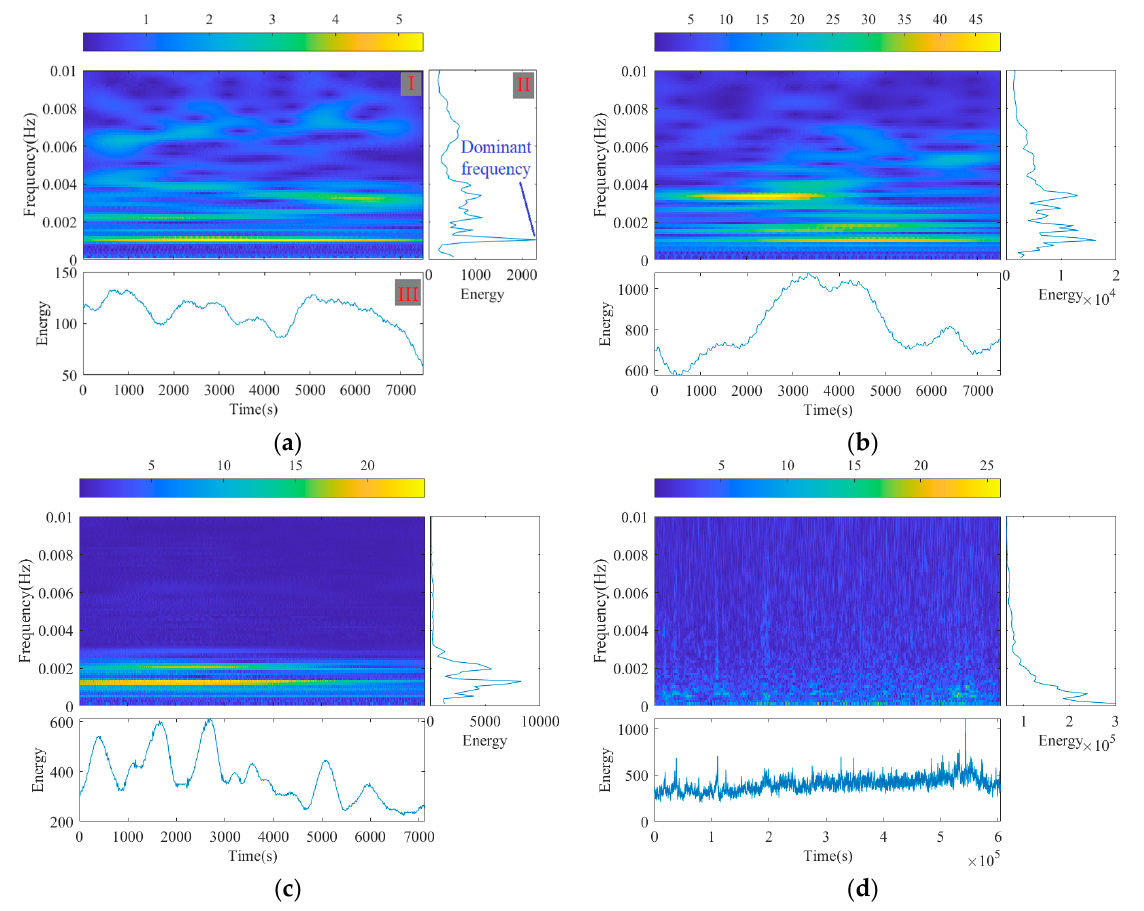
Figure 8. Time-frequency plane of EMR signals. ( a ) Environmental noise. ( b ) Drilling. ( c ) Scraper loader. ( d ) Danger signal.